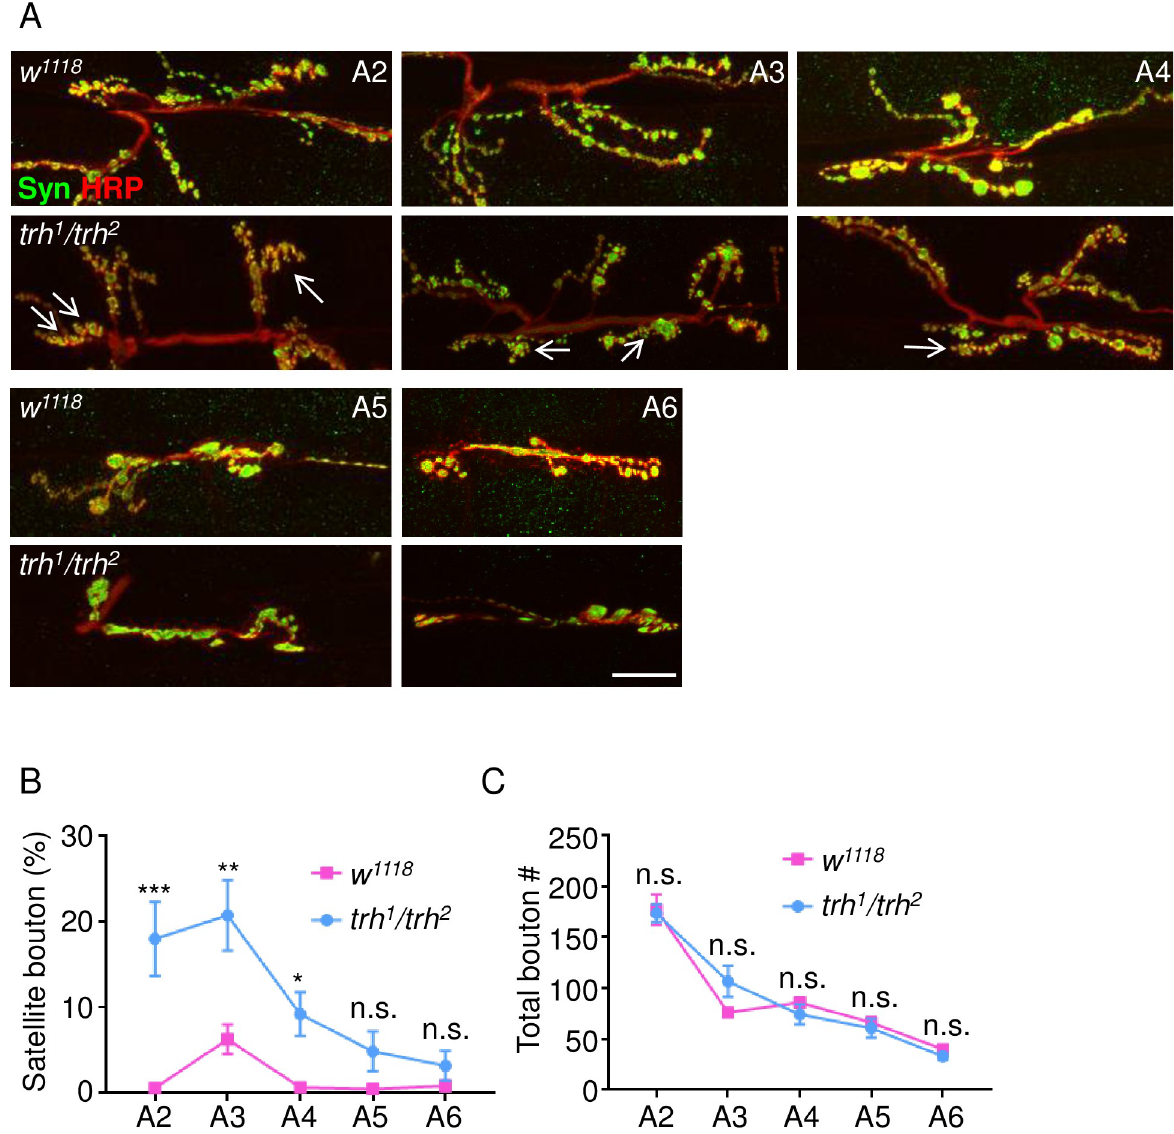
Fig 7. Selective satellite bouton formation at anterior segments of trh NMJs. (A) Images show NMJ 6/7 from segments A2-A6 immunostained for Syn (green) and HRP (red) in w 1118 and trh 1 / trh 2 . White arrows indicate clusters of satellite boutons. Scale bar represents 10 μ m. (B, C) Line graphs show average percentages (mean ± SEM) of satellite boutons (B) and total bouton numbers (C) for w 1118 (magenta lines) and trh 1 / trh 2 (blue lines). Statistical significance by Mann-Whitney test is shown (n.s., no significance; � , p < 0.05; �� , p < 0.01; ��� , p <